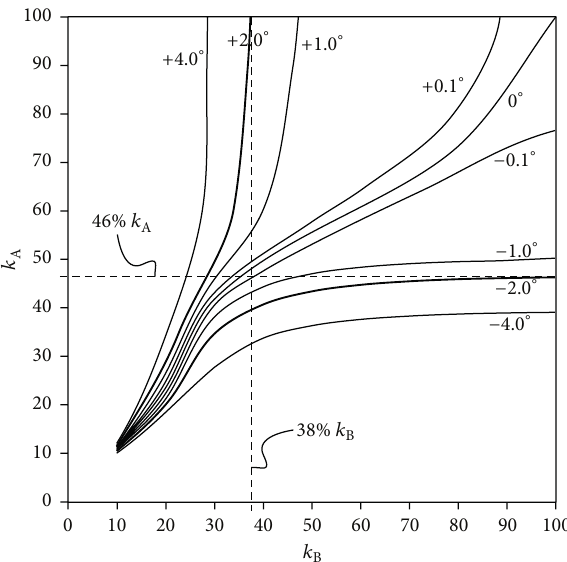
Figure 9: Angle deviation in the movement of the center of mass, full